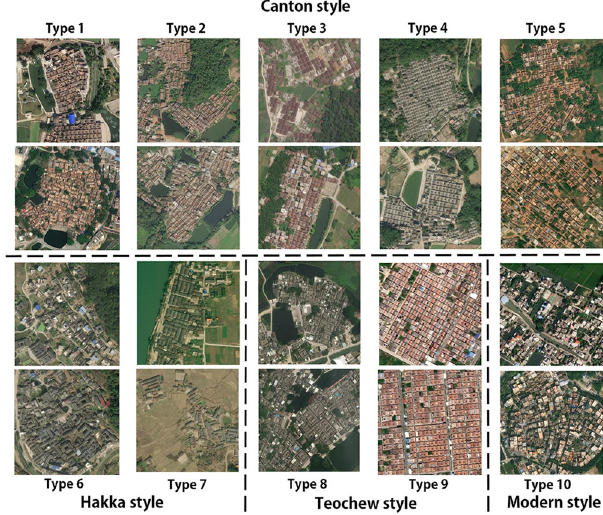
Fig. 3 The example images per village style. The images of Type 1 – Type 5 show examples of Canton villages; the images of Type 6 and Type 7 for Hakka villages; the images of Type 8 and Type 9 for Teochew villages; and the images of Type 10 show modern